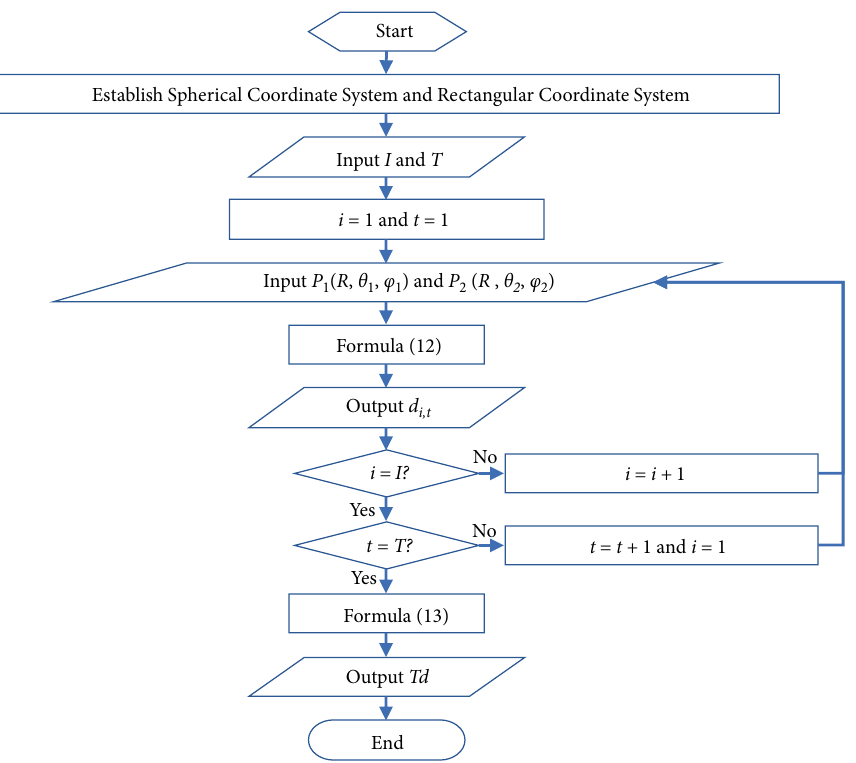
Figure 3: Flow chart of original